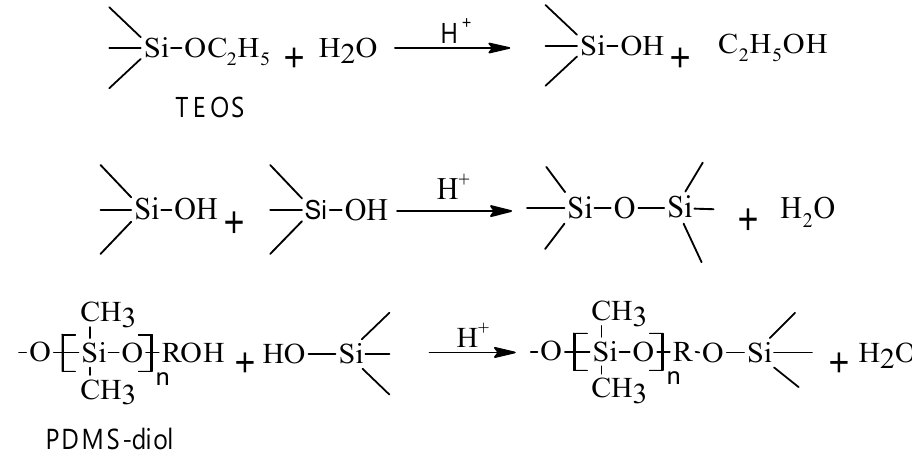
Figure 1. Preparation of silicone nanoparticles from TEOS and PDMS-diol.